Question: Produce a descriptive caption suitable for publication.
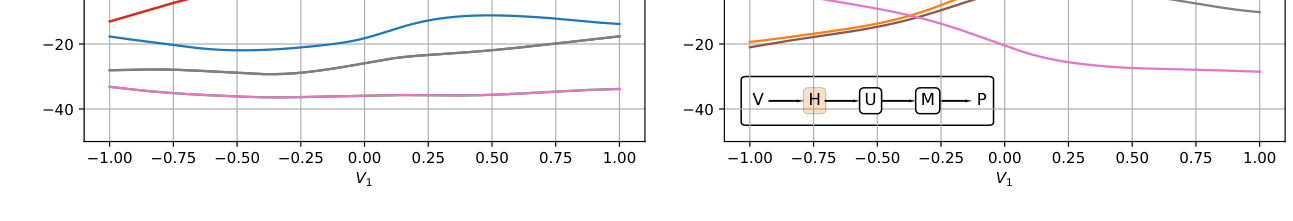
Answer: Dependence of the Hamiltonian elements to a subset of input voltages, as predicted by the graybox model. (a) Real and (b) imaginary parts of the Hamiltonian matrix elements as a function of voltage when all electrodes are grounded except the first electrode. It should be noted that the imaginary parts of H11, H22, and H33 are by definition equal to zero. The non-linear dependence, the second off-diagonal elements, and the imaginary components indicate an effective Hamiltonian being estimated for a time-dependent system, attributed to non-homogeneity of the chip along the propagation direction.